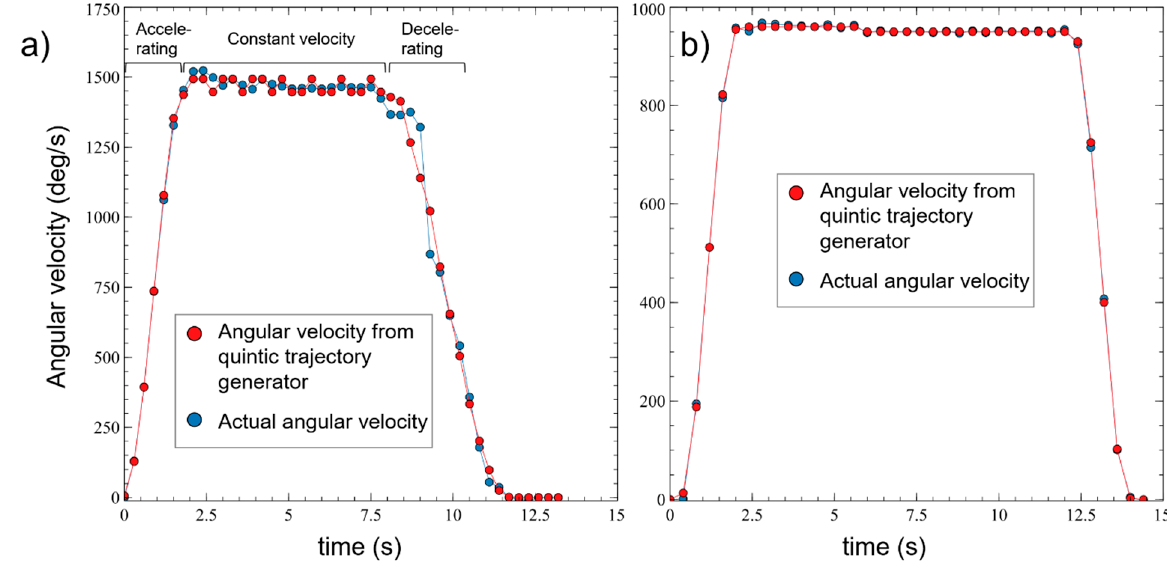
Figure 5. Comparison of the angular velocities for the conditions of ( a ) no load and ( b ) with load.